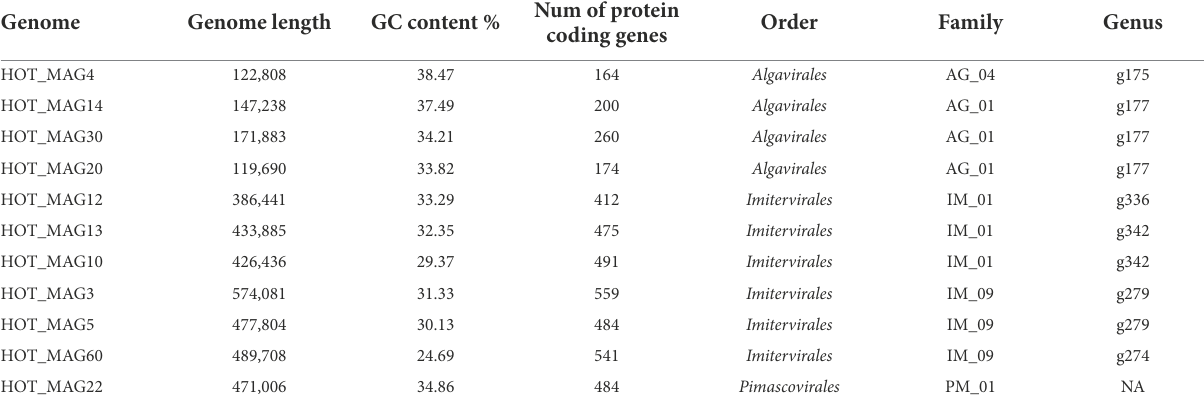
TABLE 1 General characteristics of 11 metagenome-assembeled genomes (MAGs) of giant viruses generated from St. ALOHA. Genome Genome